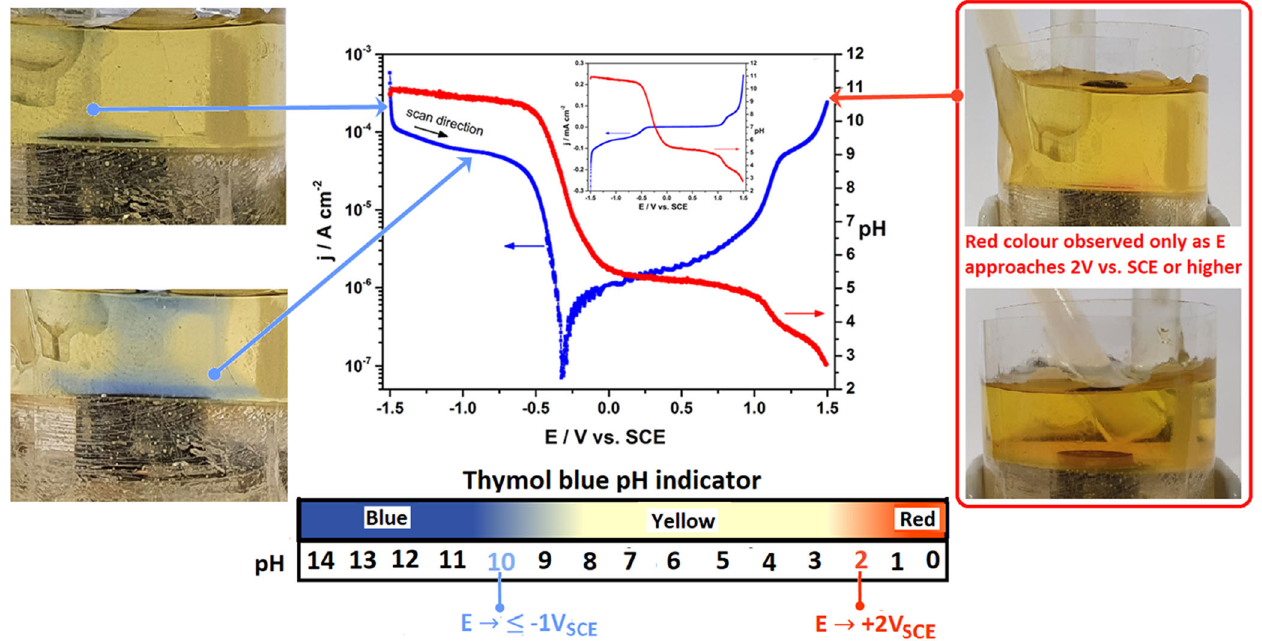
Fig. 6 pH and current density pro fi les on CFRP subjected to linear polarization. pH pro fi le of CFRP in 50 mM NaCl measured simultaneously with polarization from − 1500 to + 1500 mV SCE using a step size of 1 mV and scan rate 1 mV s − 1 . (Inset is a linear plot of the same data, and pictures indicate changes in solution colour in the presence of thymol blue pH indicator at different